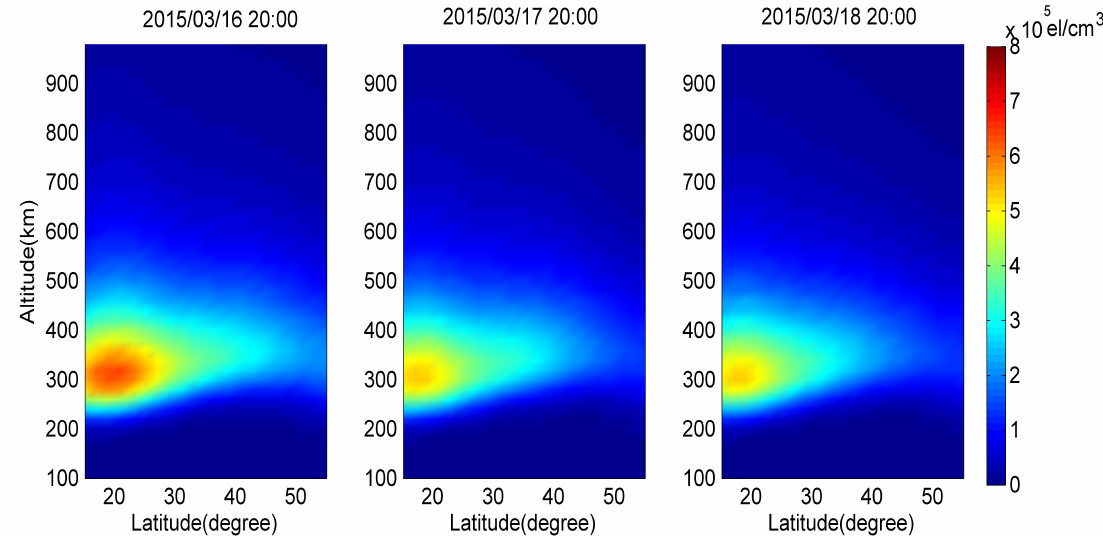
Figure 12. IED profile along latitude and altitude at UTC 20:00 from 16–18 March 2015 (L = 110 ◦